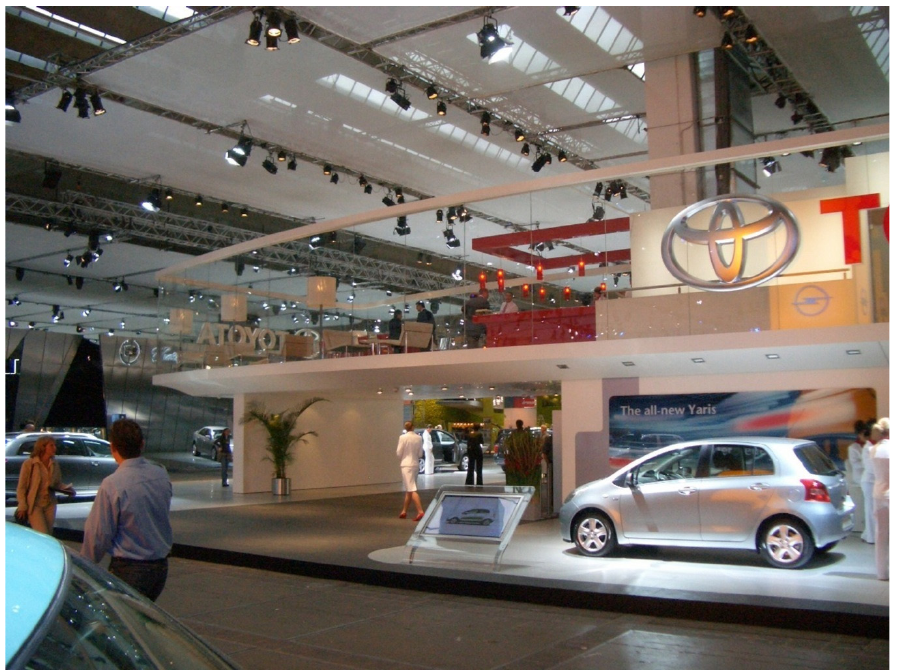
Figure 1: Front view of the exhibition